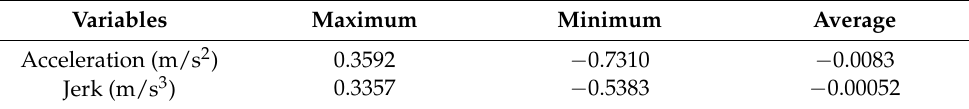
Figure 22. The simulation results of cut-in beyond a safe distance scenario: ( a ) the velocity of the host vehicle and the cut-in vehicle; ( b ) the relative distance between vehicles; ( c ) the acceleration of the host vehicle; and ( d ) the jerk of the host vehicle. Table 2. Statistics of the acceleration and jerk of the host vehicle under driving scenario